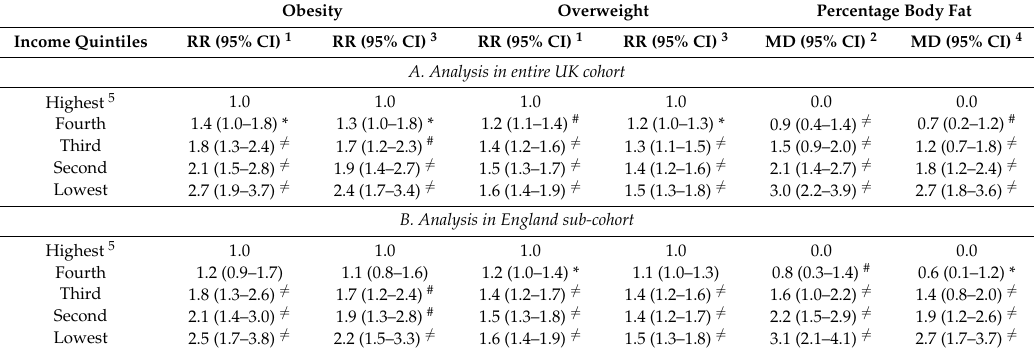
Table 3. Risk of obesity, overweight and adiposity by equivalised family income quintiles in the entire UK cohort (A) and in the England sub-cohort (B). Obesity Overweight Percentage Body